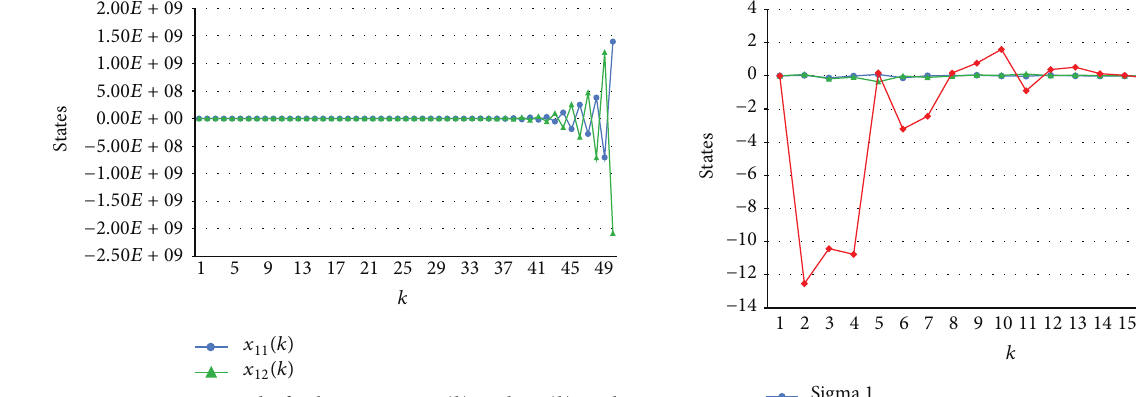
Figure 4: States respond of subsystem 1, 𝑥 11 (𝑘) and 𝑥 12 (𝑘) under feedback control, without discrete-time integral VSC.